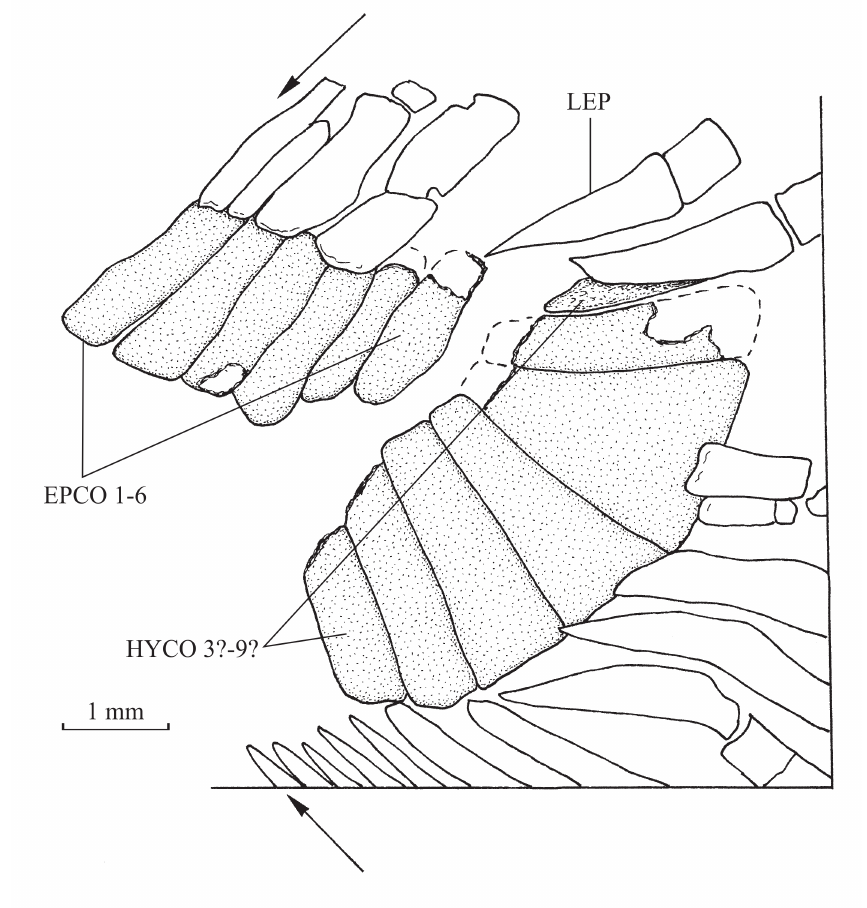
Fig. 15. Joinvillichthys kriweti gen. et sp. nov. Caudal skeleton of holotype, CLC S-137. The arrows indicate the positions of the most external dorsal and ventral procurrent rays of the caudal